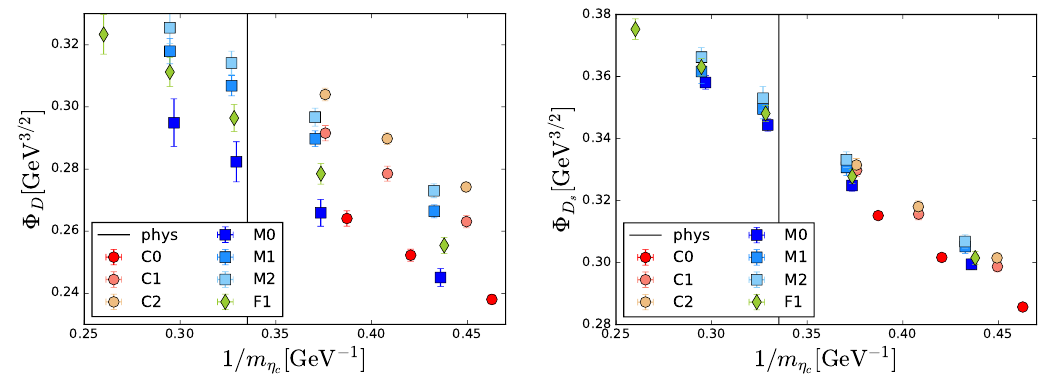
(right) as a function of the inverse (cid:17) c mass for s